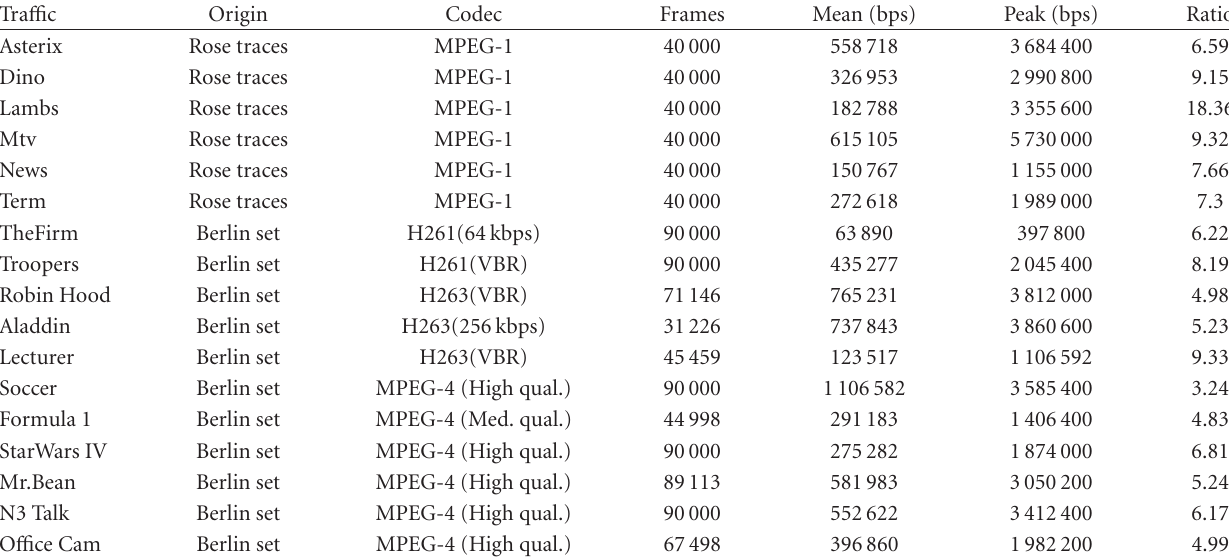
Table 2: Tra ffi c aggregate